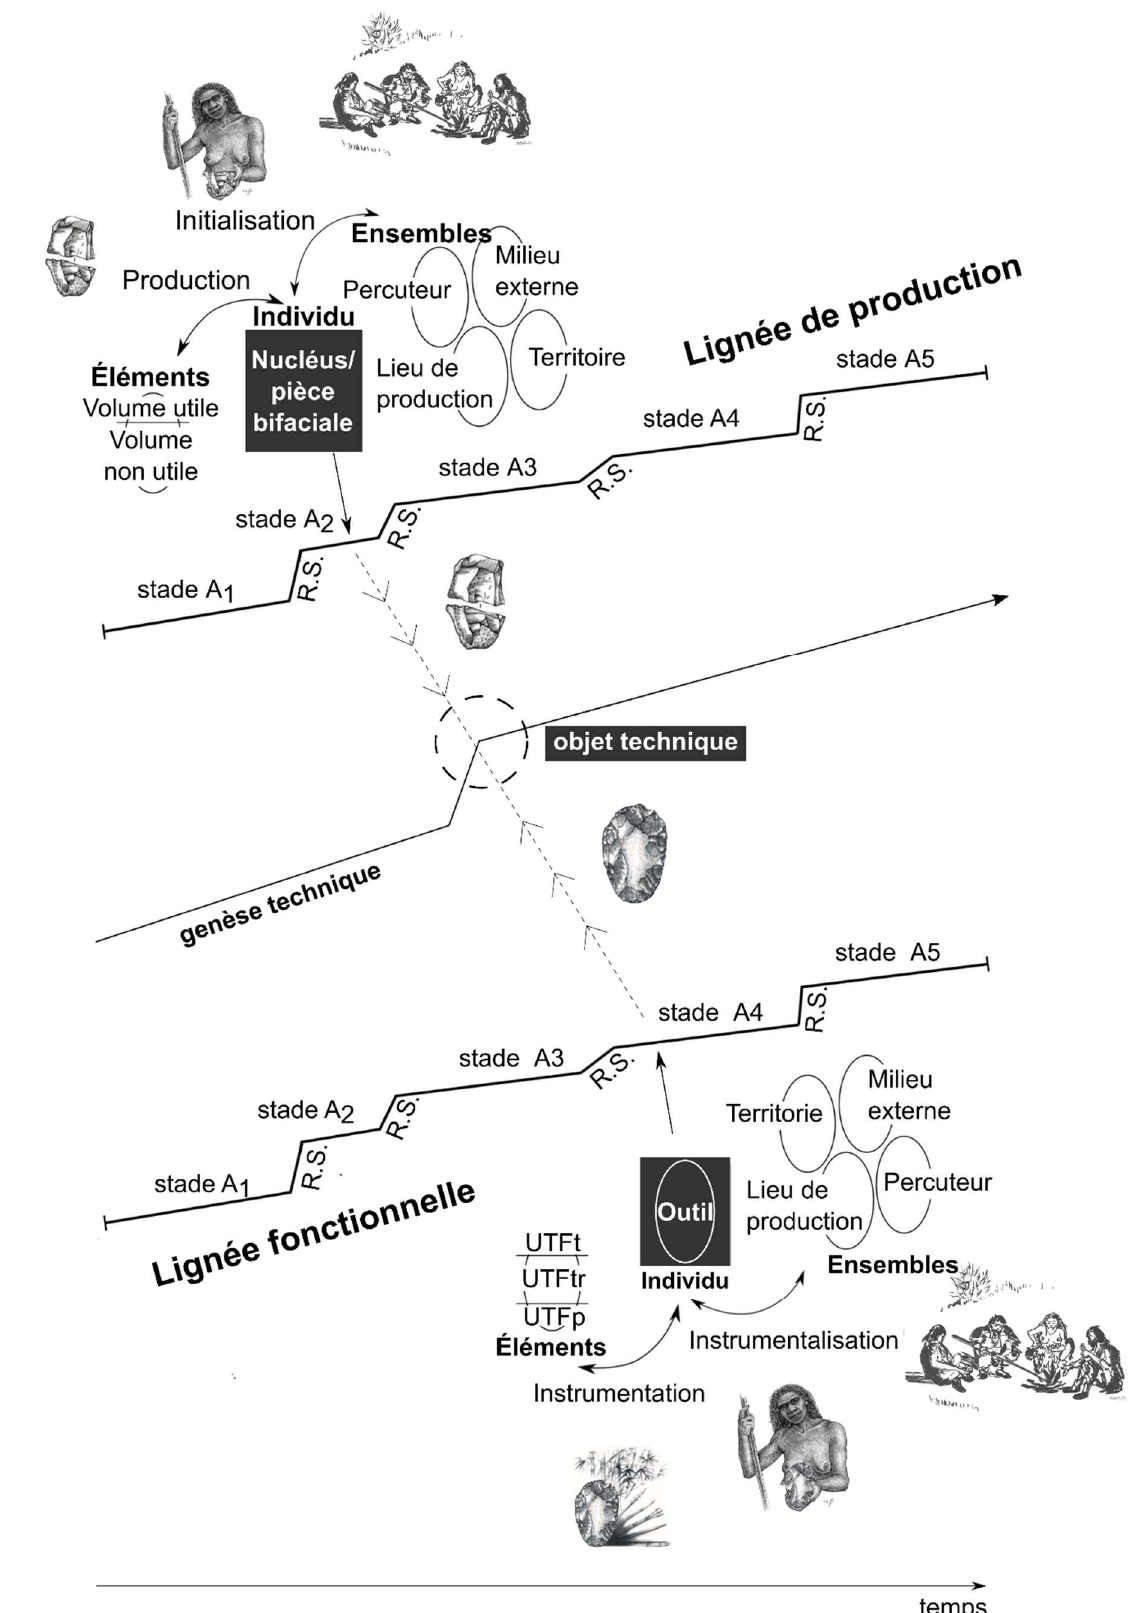
Figure 14. Structure des lignées techniques en préhistoire: les lignées de production et de fonction sont indépendantes à un moment donné de l'analyse, mais doivent ensuite être abordées ensemble pour essayer d’appréhender la genèse technique. Les dessins ont été réalisés par Maxence Raffi, Hubert Forestier et Aurore de